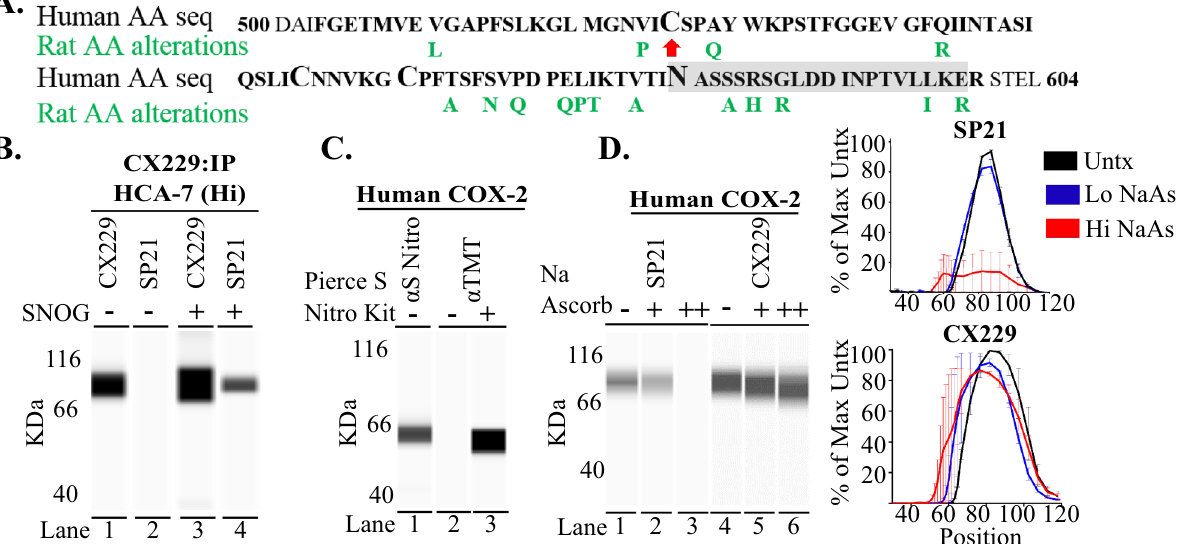
Fig. 2 SP21 recognizes S-nitrosylated COX2. A Human and rat amino acid (AA) sequence of PTGS2 gene region used as immunogens (SP21 = black bold and CX229 = gray box). Potential posttranslational modi fi cation (larger font size) S-nitrosylation site is seen at cysteine 526 (red arrow), disul fi de bond sites at AA 555 and 561, and a glycosylation site at AA 580. B COX2 immunoprecipitation (IP) of HCA-7 cell lysate using CX229 is recognized by CX229 (lane 1), but not SP21 (lane 2). On biochemical S-nitrosylation of the CX229 IP, SP21 regains reactivity to COX2 (lane 4). C Western blot analysis con fi rms recombinant human COX2 protein contains the S-nitrosylated form of COX2 as detected by a pan- nitrosylation speci fi c monoclonal antibody (lane 1), as well as by assessment of nitrosylation modi fi cation using the Pierce S-nitrosylation kit and the anti-TMT antibody (lanes 2 and 3). D Western blot analysis con fi rms dose-escalating Na ascorbate treatment ( − , + , ++ ) used for de- nitrosylation of recombinant human COX2 protein results in dose-dependent loss of SP21 signal (lanes 1 – 3). No or minimal loss of CX229 reactivity was observed after Na ascorbate treatment (lanes 4 – 6). Quantitation of COX2 western blots from three separate Na ascorbate experiments (right panel